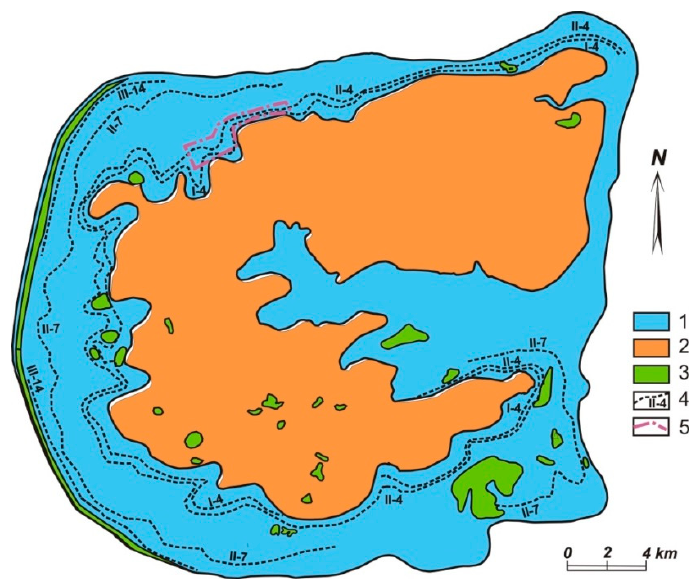
Figure 2. Geological sketch-map of the Lovozero massif (based on the map of PGO Sevzapgeologiya). Rocks of the differentiated (1) and eudialyte (2) complexes; poikilitic syenites (3); marker ore horizons (4); mining area of the Lovozero loparite deposit